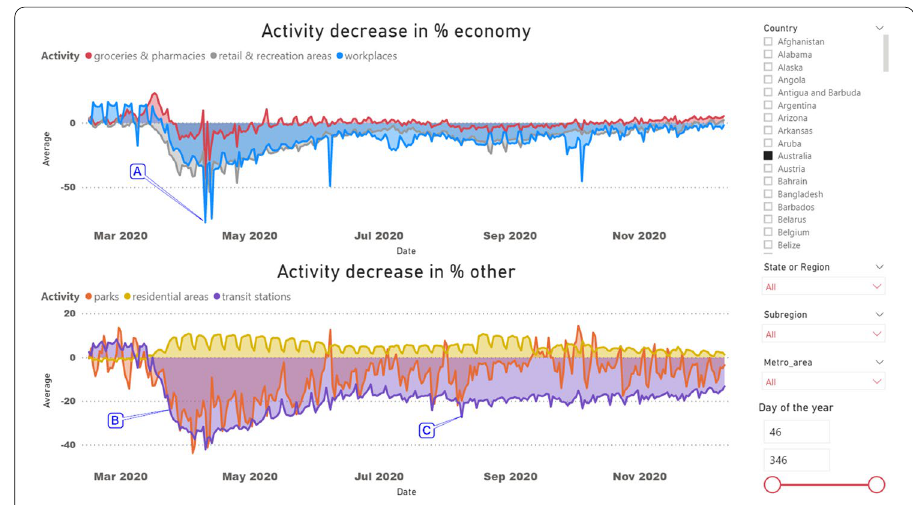
Fig. 2 Google Mobility for Australia visualized in MS PowerBI